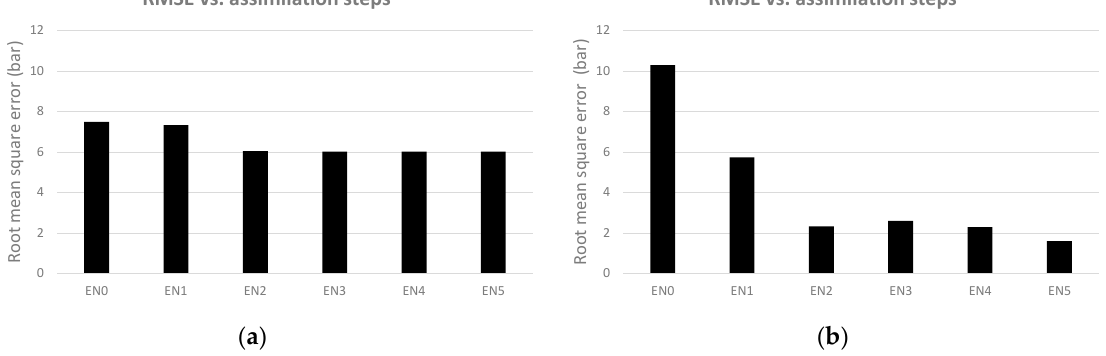
Figure 3. The root mean square error (RMSE) for the history-matching quality over the assimilation steps, geological scenario mix. ( a ) Results with Monte Carlos sampling; ( b ) and the sampling procedure proposed by the